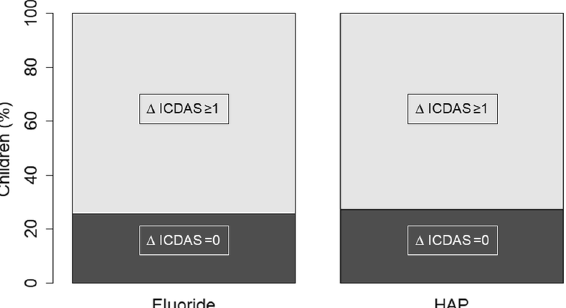
Figure 2. Increase in ICDAS ≥ ∆1 in the fluoride, and HAP-group. In both groups, the proportion of children who developed at least on one tooth a caries lesion of ICDAS ≥ ∆1 is not significantly different (more details are shown in Table 2).